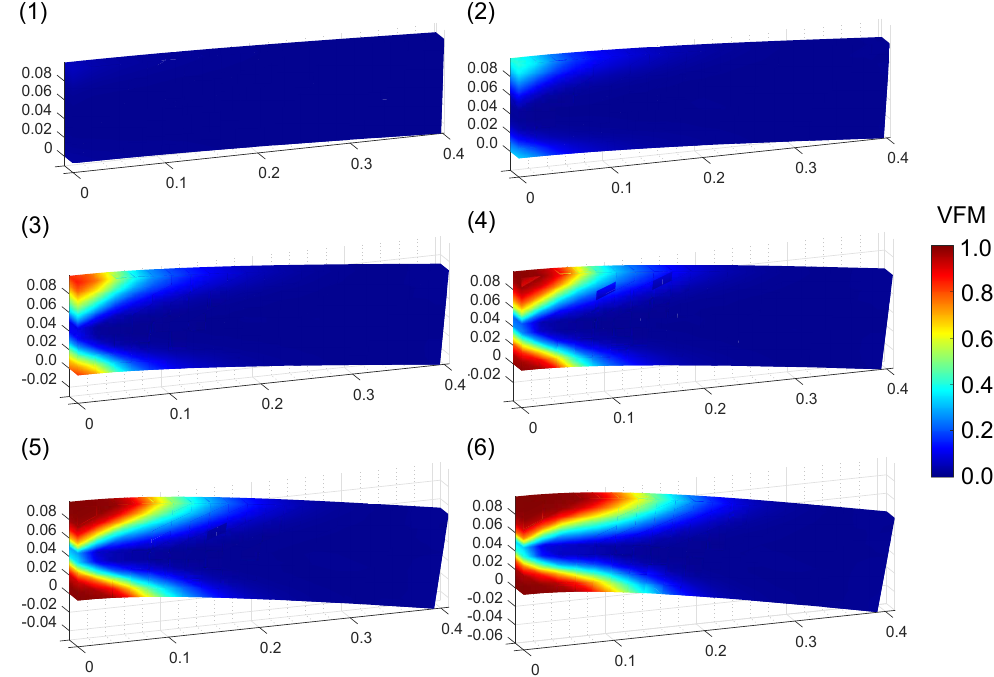
Figure 5. Simulation of bending a beam at 25 ◦ C. The color maps show the distribution of volume fraction of martensite (VFM) at six loading increments; the colorbar applies to all six plots (Example